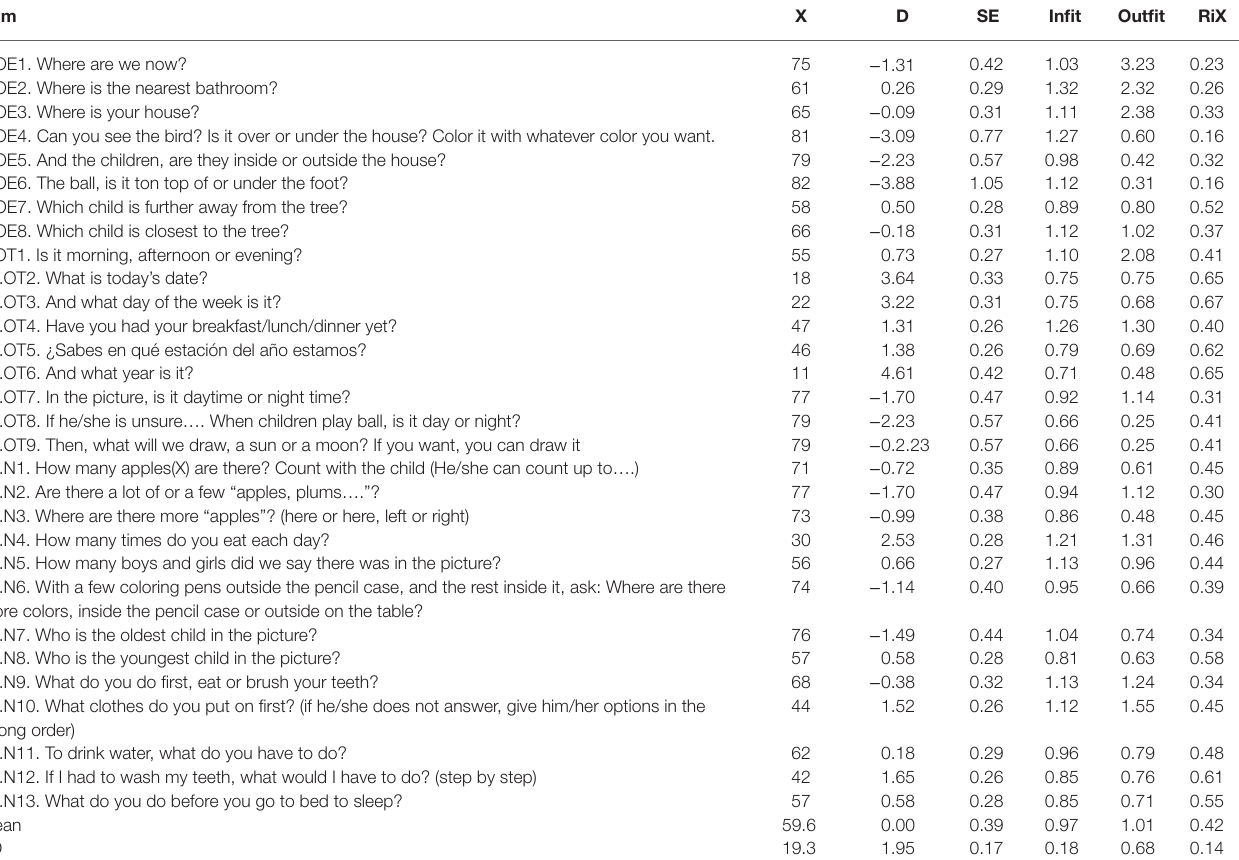
TABLE 8 | CAPALIST-contextual information. Item properties. Item X D SE Infit Outfit